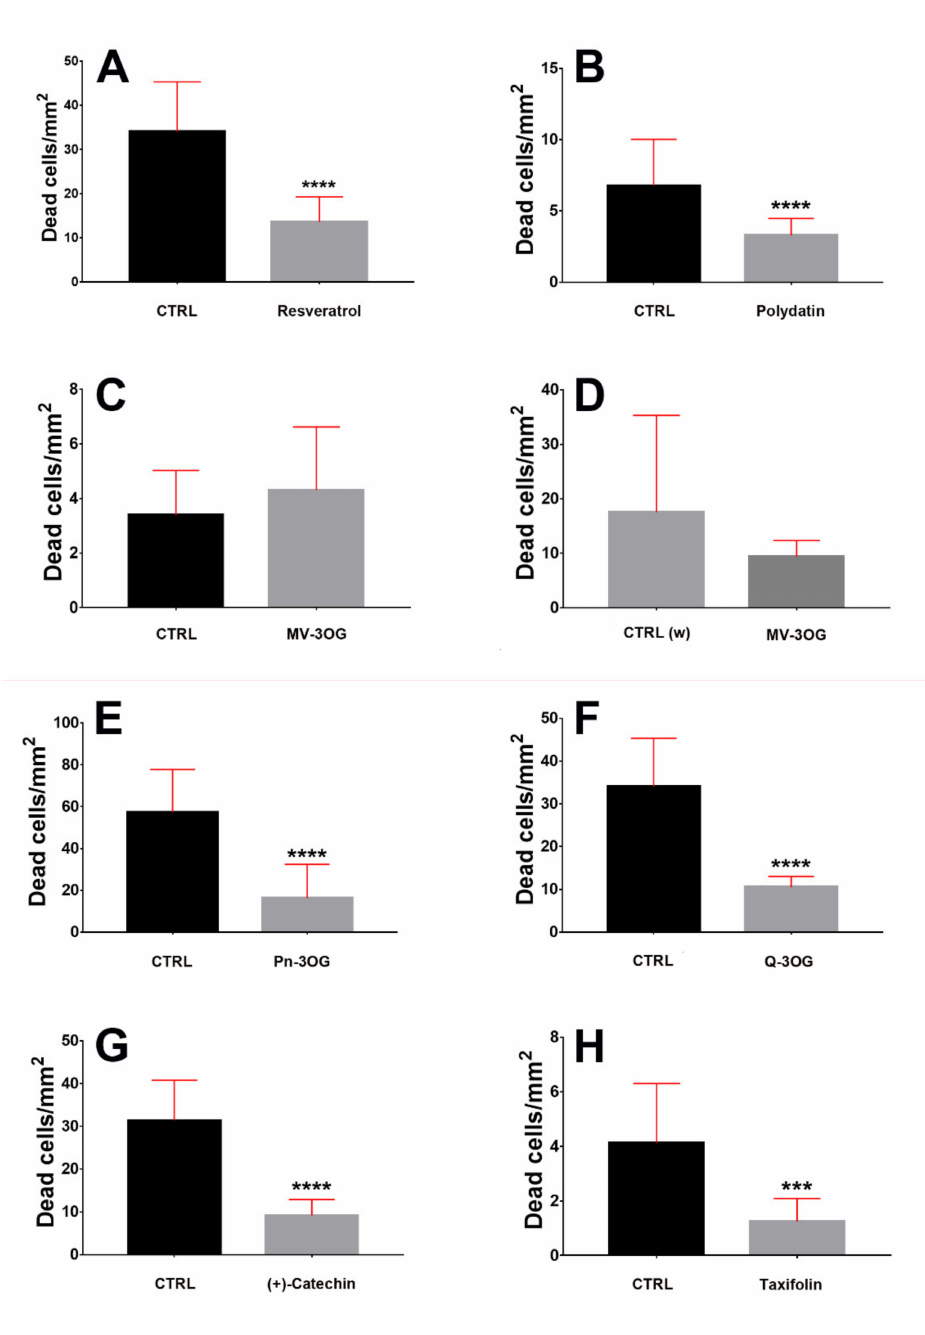
Figure 5. Inferential statistics of the e ff ects of di ff erent polyphenols (( A ) = resveratrol; ( B ) = polydatin; ( C ) = Mv-3OG (malvidin 3-O-glucoside); ( D ) = aqueous medium-dissolved Mv-3OG; ( E ) = Pn-3OG (peonidin 3-O-glucoside); ( F ) = Q-3OG (quercetin 3-O-glucoside); ( G ) = ( + )-catechin; ( H ) = taxifolin) on cerebellar naturally occurring neuronal death (NOND). Dead cells were stained with propidium iodide and results are expressed as means of dead cells / area. The two-tailed Mann-Whitney test was applied, as data did not pass the D’Agostino and Pearson normality test. *** 0.0001 > p > 0.001, **** p < 0.0001. Bars are 95% CI. All PPs except Mv-3OG (C-D) reduced NOND in cerebellar slices. Abbreviations: CTRL = control medium containing 170 mM ethanol; CTRL (w) = control medium (aqueous). We also observed that all PPs were as well e ff ective in reducing ethanol-induced cell death (F = 15.11, p value < 0.0001) after Kruskal–Wallis test and Dunn’s multiple comparison test ( p